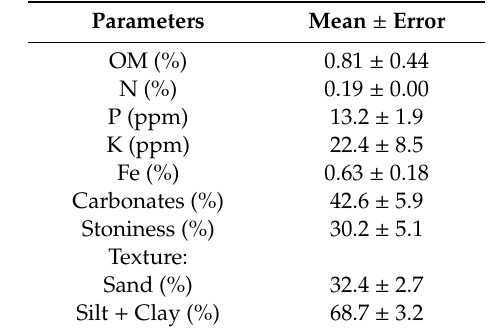
Table 1. Main soil characteristics in the area. OM: Organic matter, N: nitrogen, P: phosphorous, K: potassium, Fe: